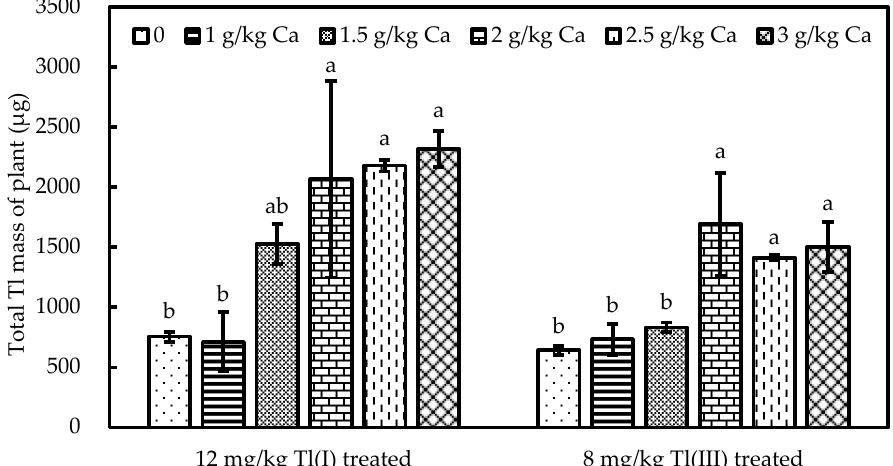
Figure 4. The exchangeable concentration of Ca in Ca-spiked pot soils. Bars denote standard deviation from means of three replicates. Significant differences among different Ca solutions are indicated by lowercase ( p < 0.05).